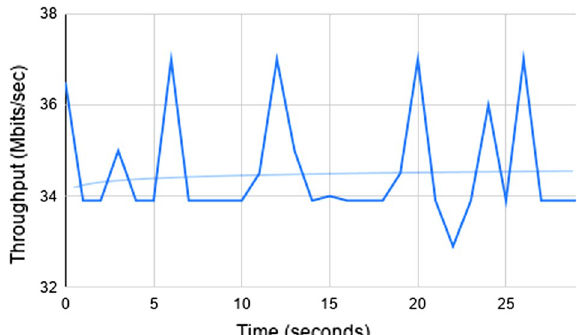
Fig. 8 iperf3 test results for throughput on the testbed for a 30 s window connecting from an edge device to the cloud services host